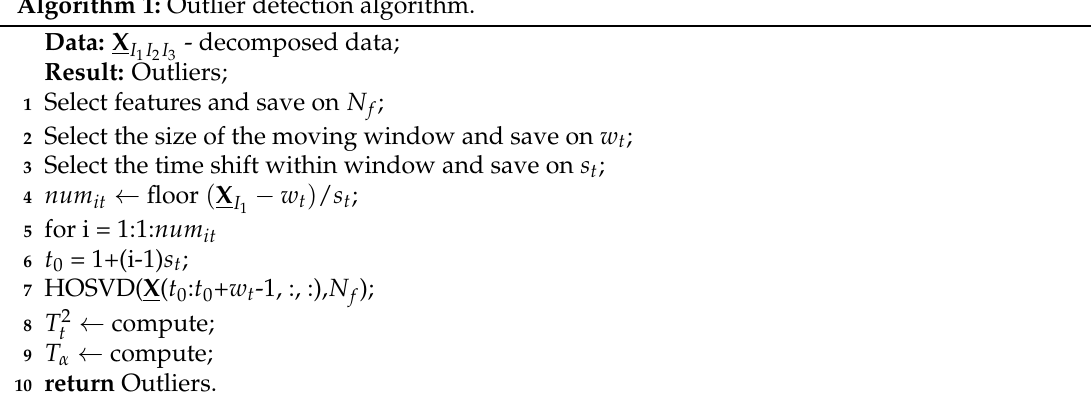
Algorithm 1: Outlier detection